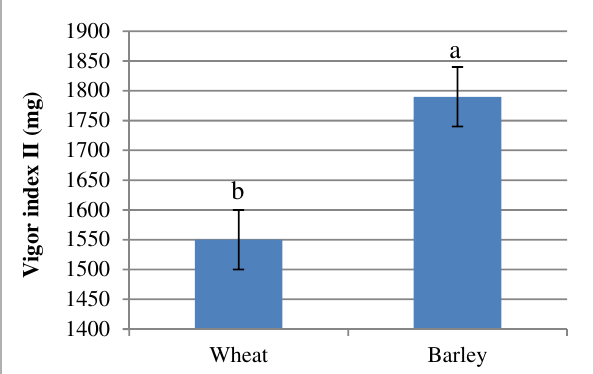
Fig. 2. Effect of plant species on vigor index II. Means by the uncommon letter are significantly different according to Duncan tests (p <